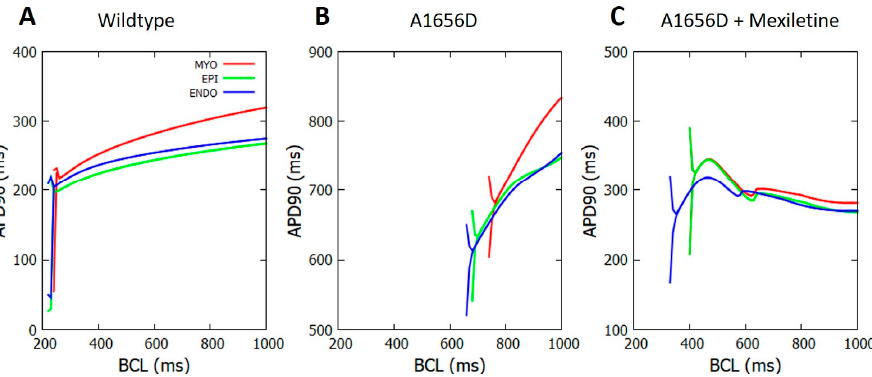
Figure 2. The APD as a function of BCL for WT, the A1656D mutant and A1656D under mexiletine. Figure 3 depicts the results of a 3D ventricular simulation. In panel A, we can see a comparison of electrical activity from the A1656D mutation and A1656D when treated with mexiletine. At 989 ms, we labeled the rotors formed upon reentry with a black star. We can see that the A1656D mutation has around five rotors in total. They are visible from the “front”, “back”, “left”, and “top” sides of the ventricular mesh. The A1656D mutation, on the other hand, has fewer rotors, with only four, one at the “front”, one at the “back”, and two at the “top” of the mesh model. The conduction velocity (CV) detected from the simulation was 19 cm/s for A1656D mutation, and 17.3 cm/s for A1656D mutation under mexiletine. Panel B compares the action potential shape of the epicardial cells with the effect of A1656D mutation and A1656D under mexiletine. The A1656D mutation resulted in a more prolonged APD as compared to the A1656D mutation when mexiletine was used.